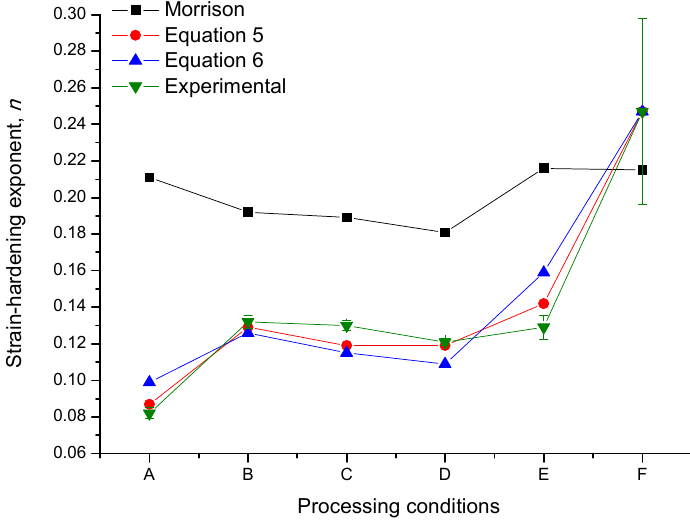
Figure 5. Strain-hardening exponent ( n ) from Morrison model, modified equations and experimental data. Where: A = straight stretch, B = Intrados , C = Extrados , D = Extrados tempered at 600 °C, E = Extrados tempered at 650 °C and F = straight stretch normalized at 900 °C.